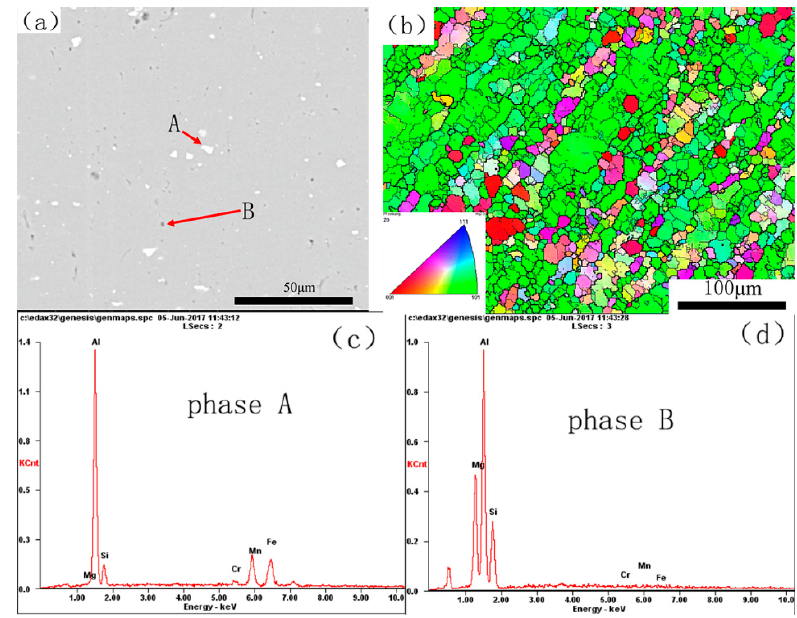
Figure 4. Secondary electron scan (SEM) micrographs ( a ), electron backscattered diffraction (EBSD) image ( b ) and energy dispersive spectrometer (EDS) spectra analysis of peak aging alloys, ( c ) Phase A: irregular block; ( d ) Phase B: granular phase/graininess.